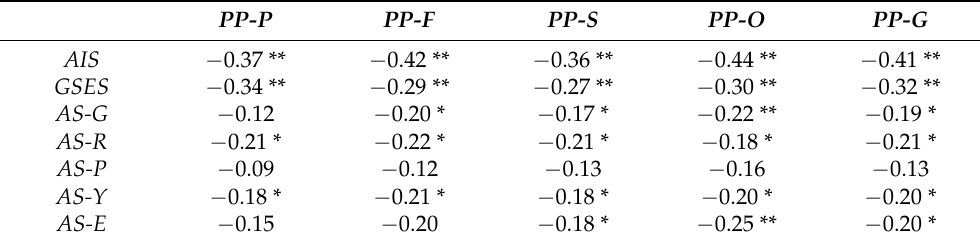
Table 2. Between-variable correlations—the E